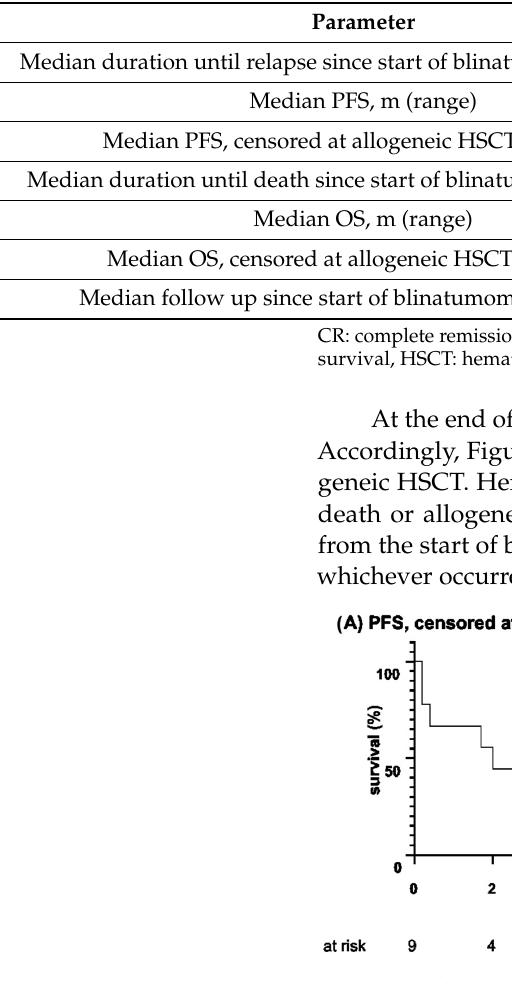
Figure 1. ( A ) Progression-free survival and ( B ) overall survival since the start of blinatumomab therapy (months). Table 6. Outcome of blinatumomab therapy. Data on medians.